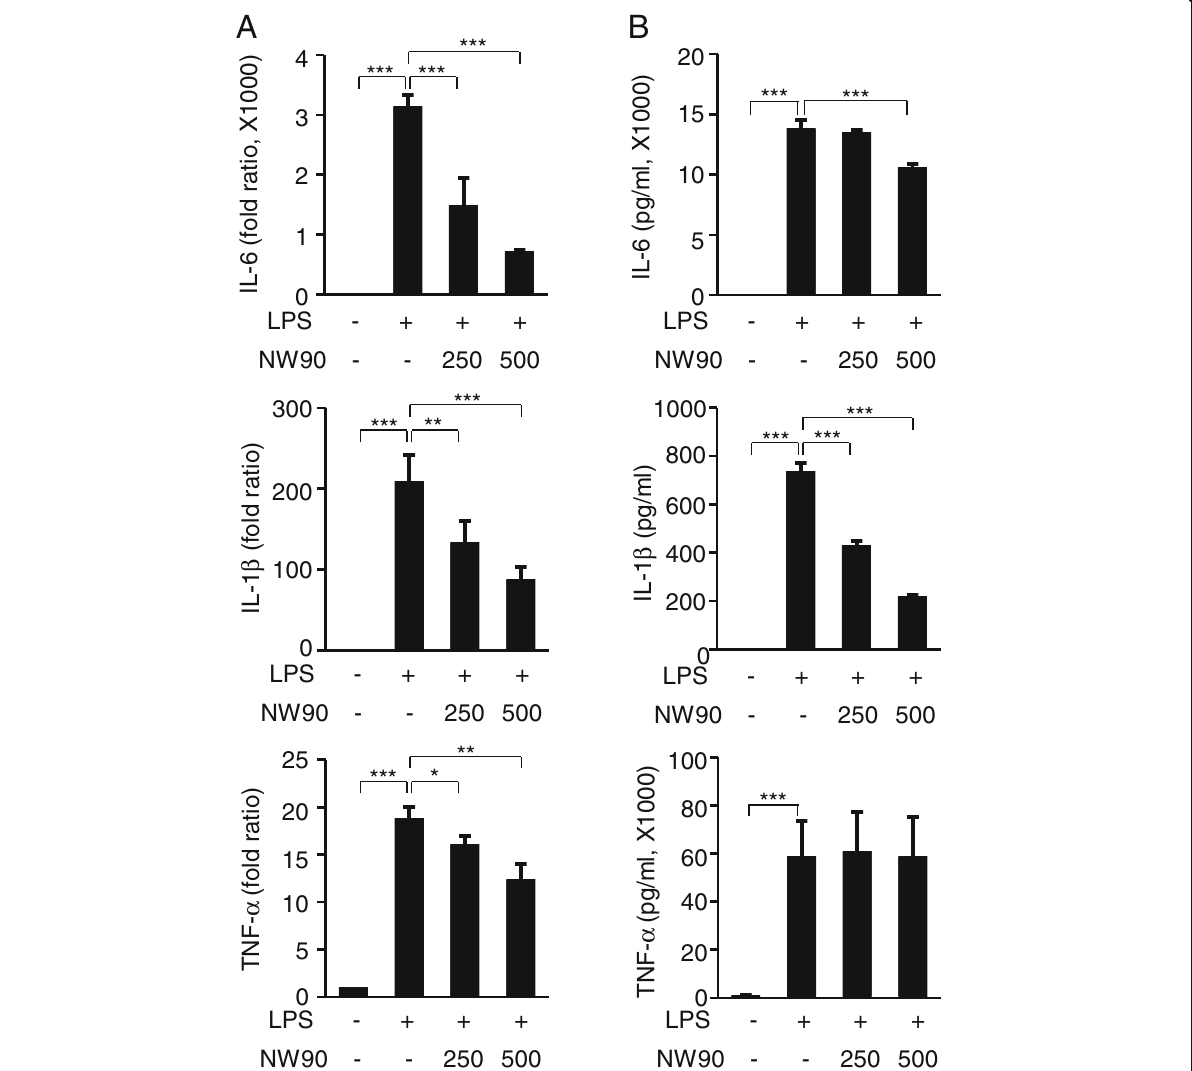
Fig. 3 Effects of Papaver nudicaule extract NW90 on the production of inflammatory cytokines. RAW264.7 cells were treated with NW90 (250 and 500 μ g/ml) and LPS (100 ng/ml) for 24 h. a Expression levels of IL-6, IL-1 β , and TNF- α mRNA were measured by real-time quantitative PCR. GAPDH was used as an internal control. b Secretion levels of IL-6, IL-1 β and TNF- α were determined by multiplex assays using the culture supernatants. Data are presented as mean ± SD from at least three independent experiments in triplicate. * P < 0.05, ** P < 0.01 and *** P < 0.001 indicate statistically significant differences compared with the group treated with LPS